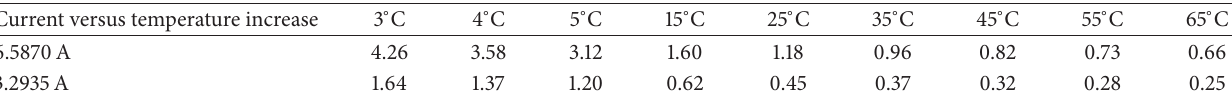
Figure 8: Front view (a) and lateral view (b) of the isothermal contours in the assembly of the full scaled board in ∘ C. Table 6: Minimum width (in mm) of the 70 𝜇 m thick copper, for ambient temperature of 25 ∘ C, depending on current and copper’s temperature (according to the IPC-2221